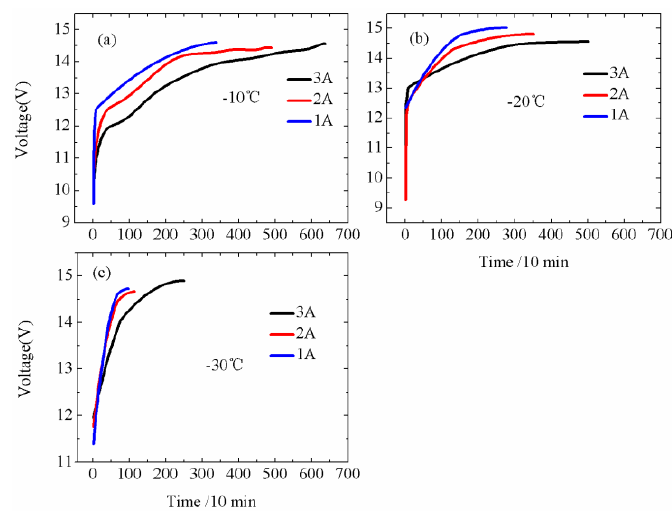
Figure 8. ( a – c ) Charging curve for the lead–acid battery at temperatures of − 10, − 20, and − 30 ◦ C under the charging currents of 1, 2, and 3 A, respectively.